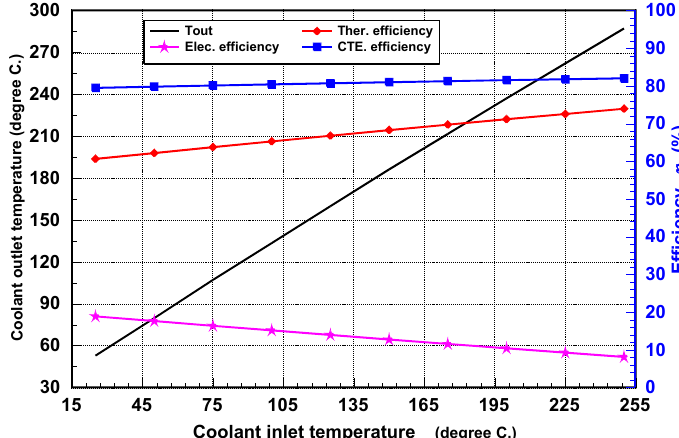
Figure 21. The variation of the CPVT collector coolant inlet temperature, electric, thermal, and CTE efficiencies with the coolant outlet temperature (constant ṁ = 0.01 kg/sec).